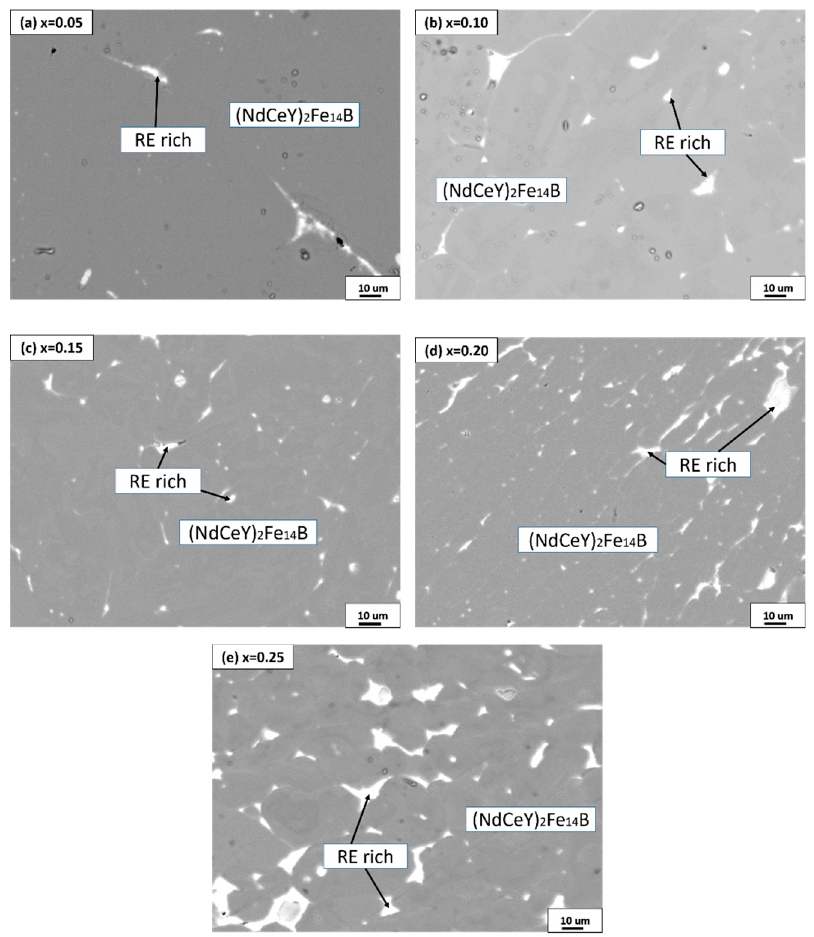
Figure 3. The backscattered electron (BSE) images of (Nd 1-2x Ce x Y x ) 14.5 Fe 79.3 B 6.2 alloys annealed 1173 K for 360 h: ( a ) x = 0.05, ( b ) x = 0.10, ( c ) x = 0.15, ( d ) x = 0.20, and ( e ) x = 0.25. Figure 4 is the XRD patterns of (Nd 1-2x Ce x Y x ) 14.5 Fe 79.3 B 6.2 melt-spun ribbons. According to the phase analysis of XRD patterns, diffraction peaks in all the ribbons are indexed as the (NdCeY) 2 Fe 14 B phase with the tetragonal Nd 2 Fe 14 B-typed structure (space group P4 2 /mnm), rich-RE ( α -Nd) phase, and α -Fe phase. Especially, the ribbon with x = 0.25 has a different phase constitution, which contains additional CeFe 2 phase.